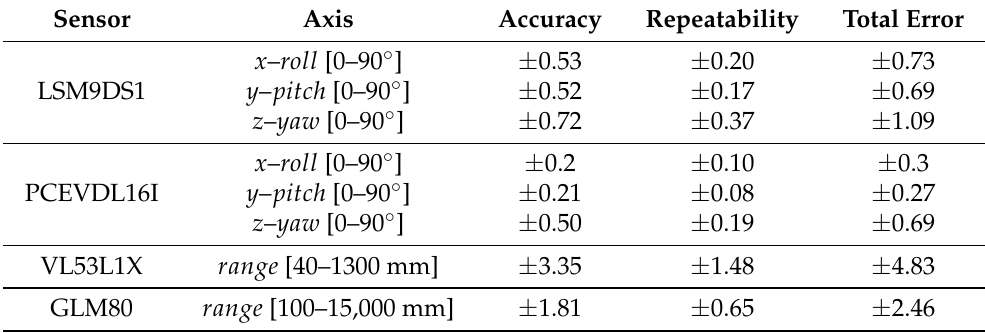
Figure 12. Results of ( a ) accuracy, ( c ) repeatability, and ( e ) total error for the sensor VL53L1X and ( b , d , f ) for the distance meter GLM80. Table 1. Results of the accuracy, repeatability, and total error for the sensors: LSM9DS1, PCEVDL16I, VL53L1X, and